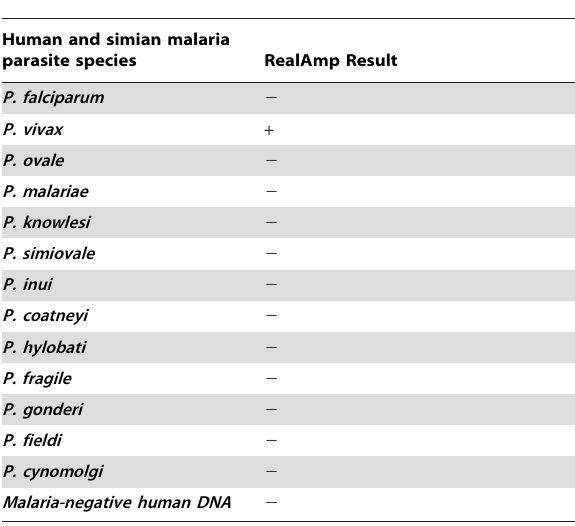
Table 2. Specificity results of the r64 primer set when tested against human-infecting and simian-infecting malaria